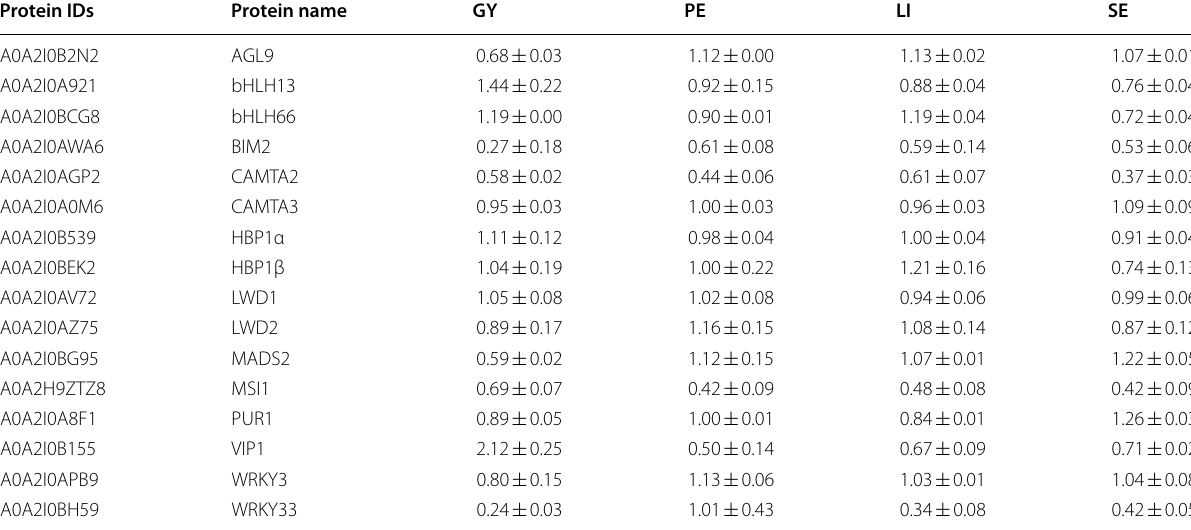
SE: Sepal; PE: petal; LI: lip; GY: gynostemium